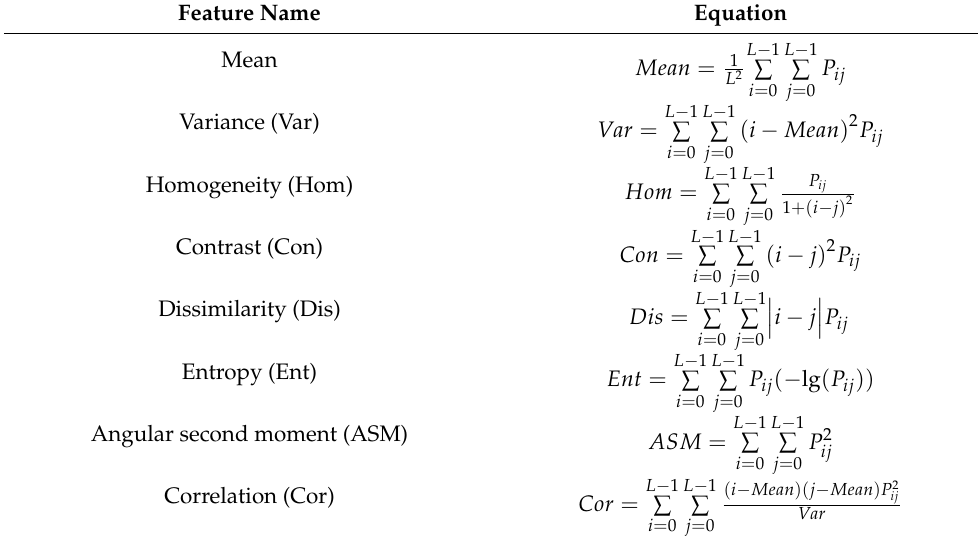
Table 1. Candidate texture features used for image